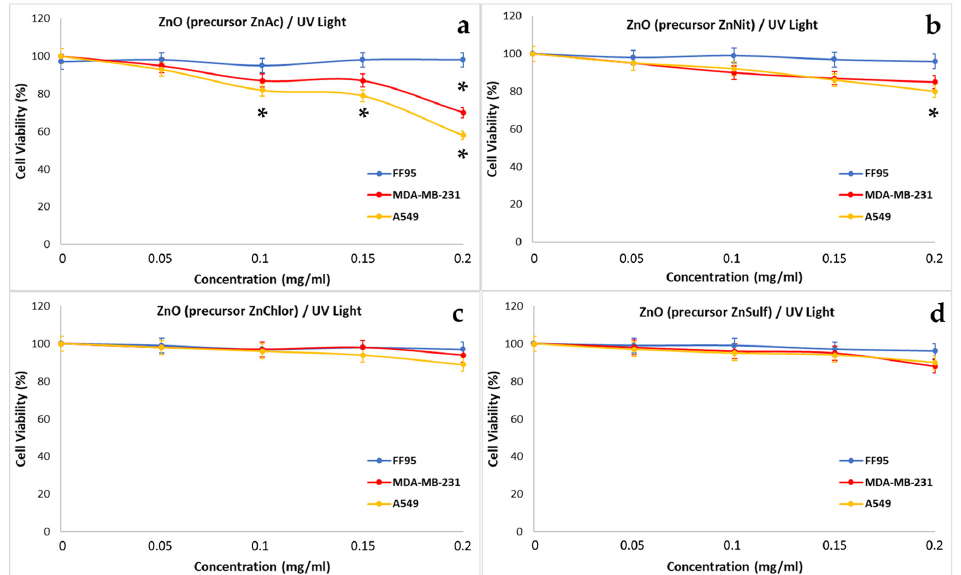
Figure 24. Effect of photo-activated with UV light ZnO nanoparticles, synthesized using as precursor: ( a ) zinc acetate dehydrate (ZnAc), ( b ) zinc nitrate hexahydrate (ZnNit), ( c ) zinc chloride (ZnChlor), and ( d ) zinc sulphate heptahydrate (ZnSulf) on FF95, MDA-MB-231, and A549 cells. There is not